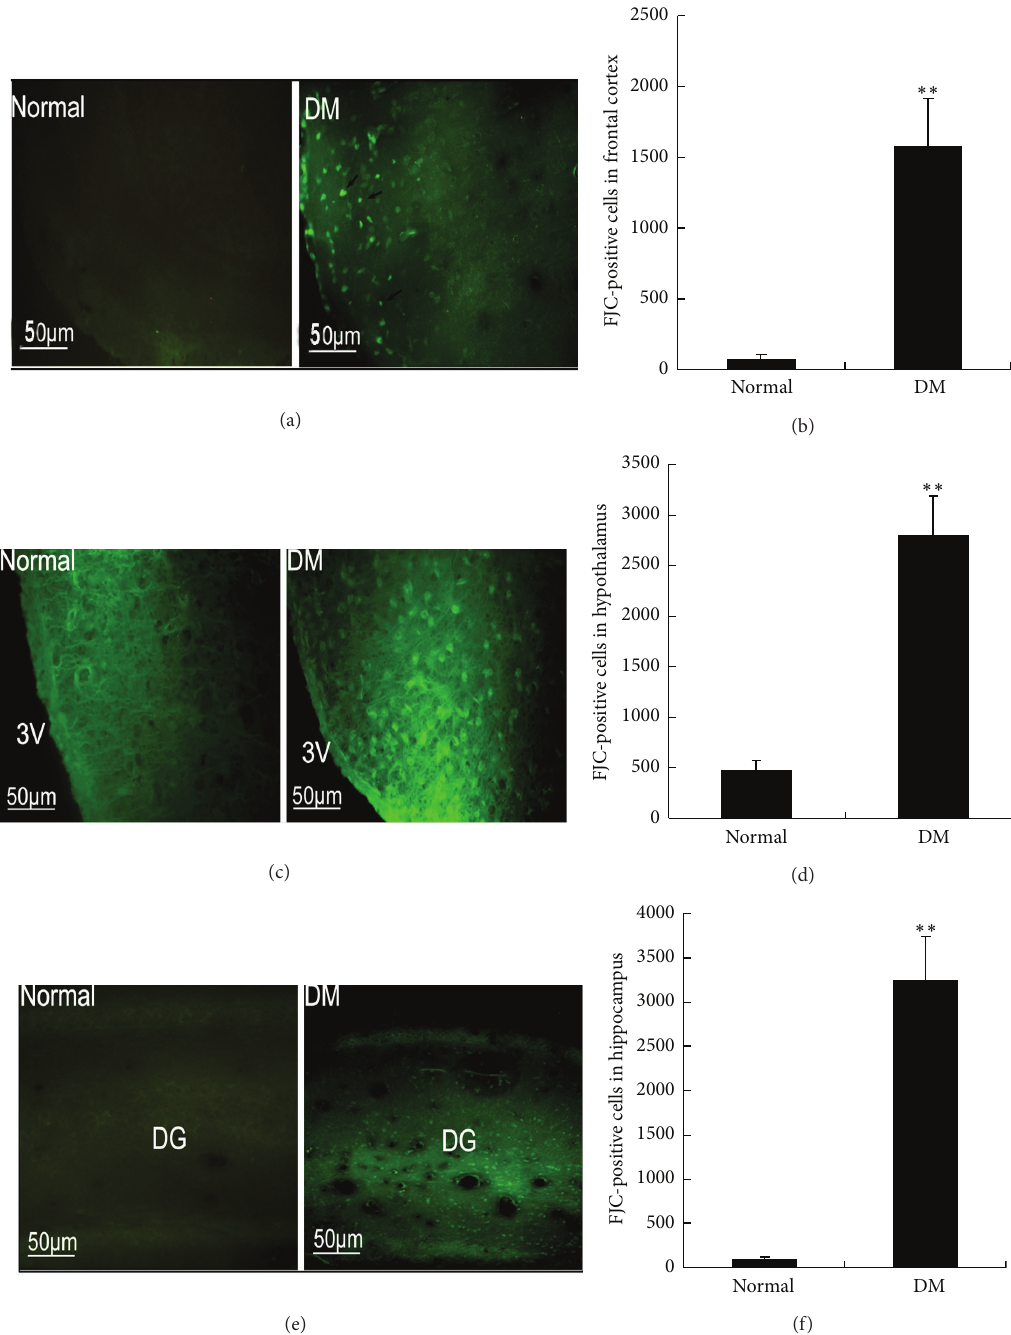
Figure 3: Fluoro-Jade C- (FJC-) positive cells were examined in the frontal cortex, hypothalamus, and hippocampus of rats at 4 months after STZ injection. (a) Representative images of FJC-positive cells in the frontal cortex. (c) Representative images of FJC-positive cells in the hypothalamus; 3V: third ventricle. (e) Representative images of FJC-positive cells in the hippocampus; DG: dentate gyrus. (b) Frontal cortex, (d) hypothalamus, and (f) hippocampus. FJC-positive cells were counted (see Materials and Methods for procedure details). ∗∗ 𝑃 < 0.01 , significant difference compared with the age-matched control rats; 𝑛 = 6